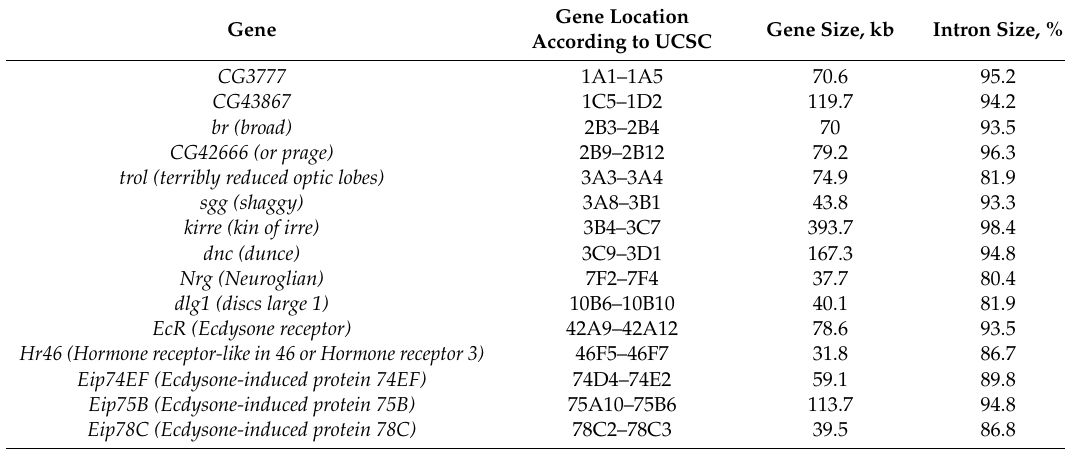
Table 1. Fifteen long genes characteristics.